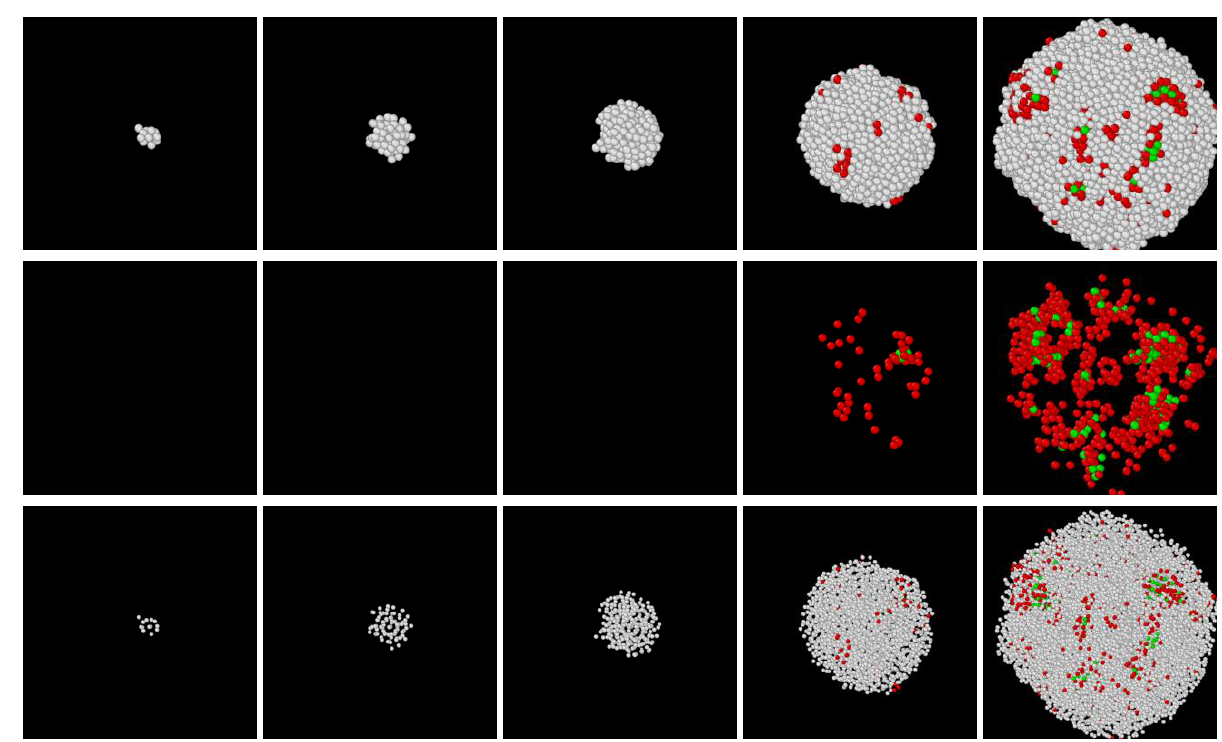
Figure 5. Snapshots of a solid cluster forming in a DPFC simulation performed at ε = 0.2 and ψ 0 = − 0.2720. The snapshots were taken at dimensionless times t = 520, 600, 700, 1000, and 1400. Coloring indicates the magnitude of q 6 . White (amorphous): q 6 < 0.28; red (MRCO): 0.28 < q 6 < 0.4; green (bcc): q 6 > 0.4. In the upper and central rows atom-size circles denote the density peaks. In the upper row atoms with all three types of neighborhoods are shown, whereas in the central row only particles of MRCO and bcc-type neigh- borhoods. In agreement with previous results for the DPFC model [28–30], the early stage of solidification is dominated by the for- mation of an amorphous precursor. In the bottom row, we used smaller spheres to indicate the position of the density peaks, which then allows us to see the presence of an ordered but non-crystalline initial structure. The ring-like ordering can only be seen from certain directions. A fraction of a 512 3 simulation is shown.